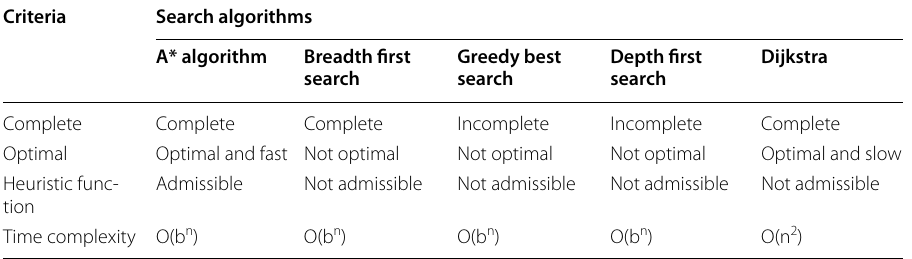
Table 2 Comparison between A* algorithm and other search algorithms (Mehlhorn et al., 2017; Potdar & Thool,